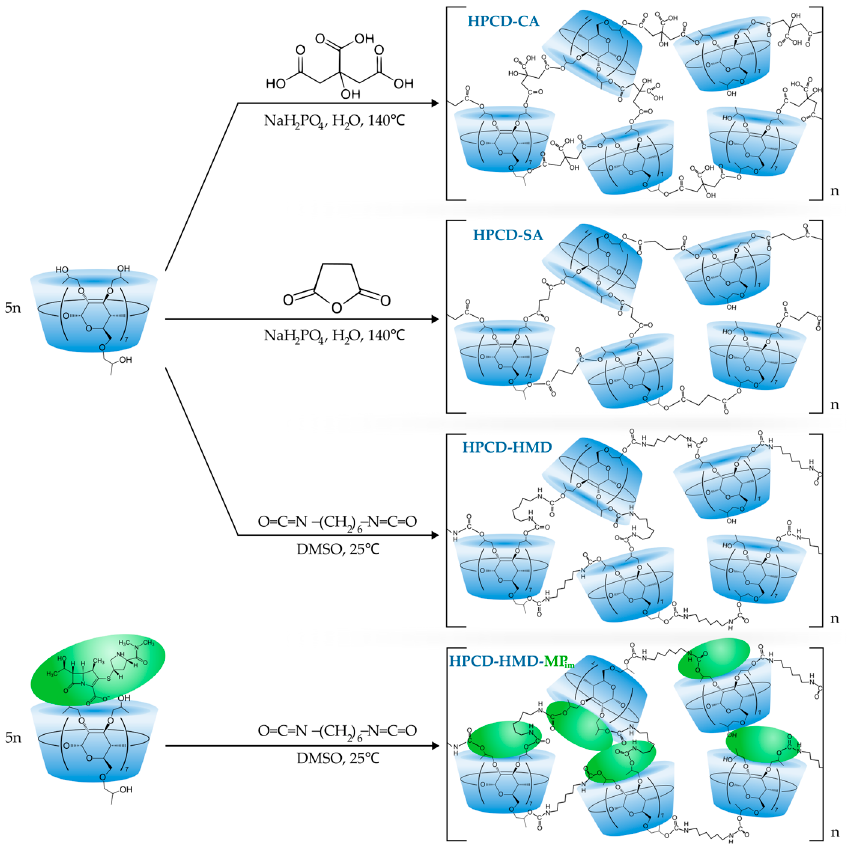
Figure 1. The scheme of HPCD-Citric acid, HPCD-Succinic acid, HPCD-HMD, and HPCD-HMD- MP im polymer synthesis.